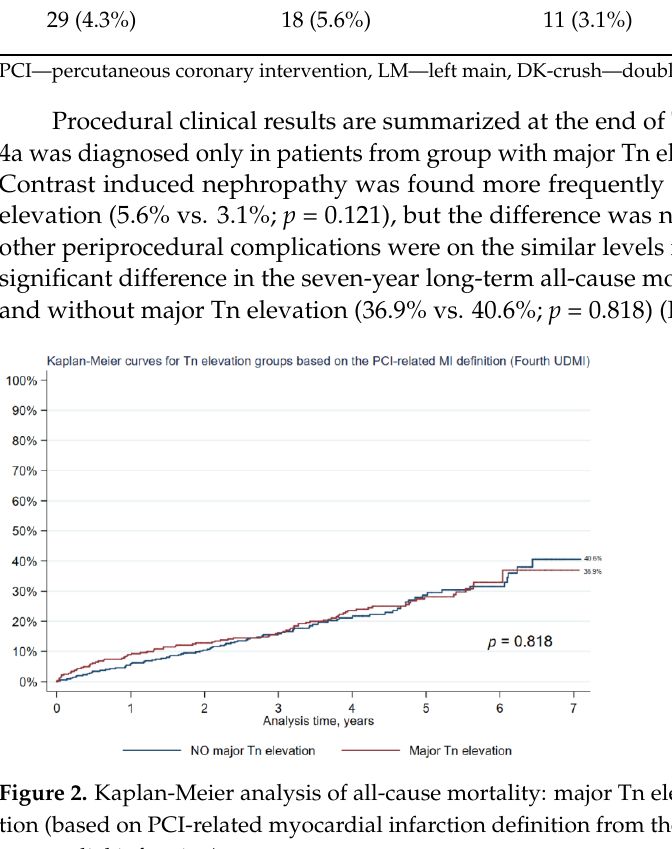
Figure 3. Kaplan-Meier analysis of all-cause mortality: Periprocedural myocardial injury vs. NO periprocedural myocardial injury (Fourth Universal Definition of Myocardial Infarction).